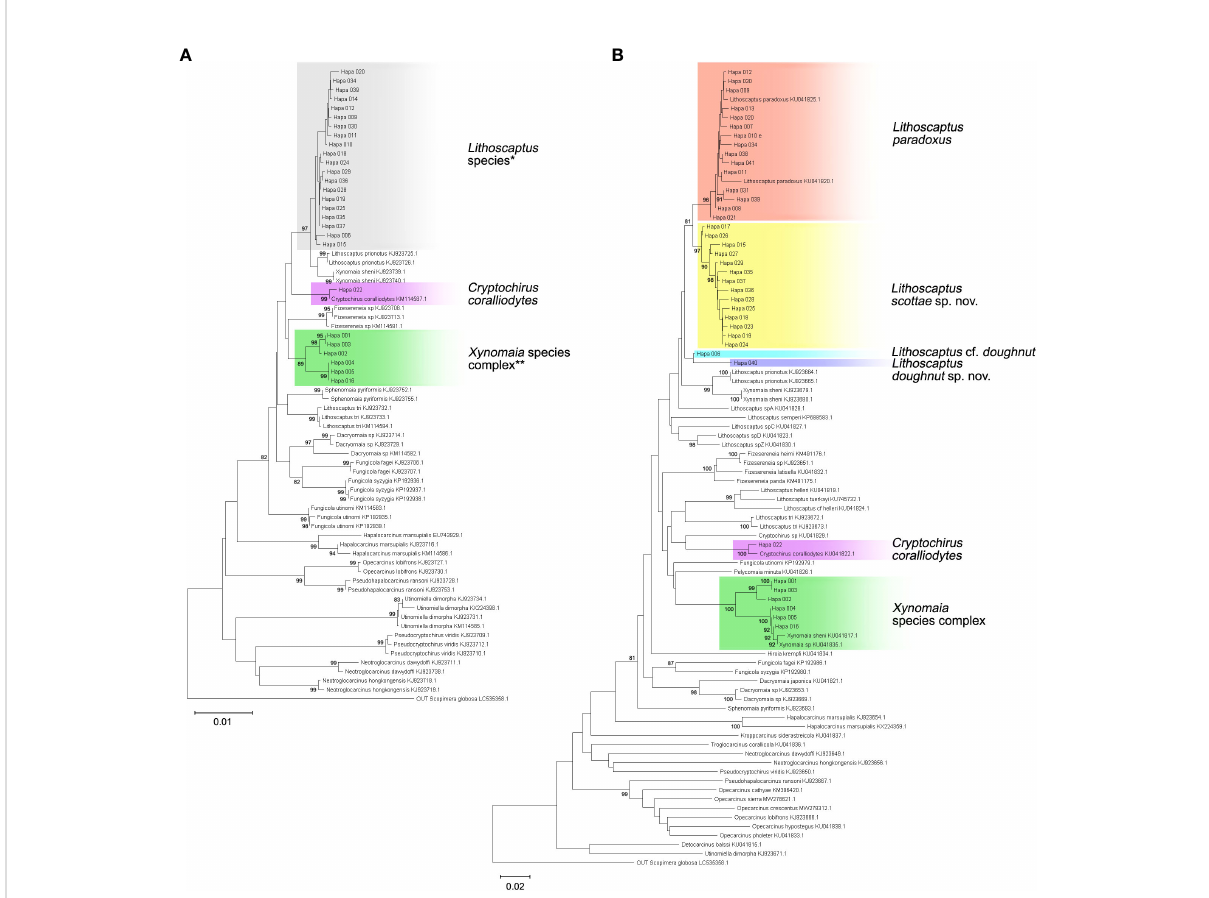
FIGURE 6 Neighbor-joining (NJ) tree of 16S rDNA (A) and COI sequences (B) . Branch length represents Kimura 2-parameter (K2P) distances, and bootstrap values are shown on the nodes when >80. Details of specimens from the present study (clades highlighted in gray), and reference sequences acquired from Genbank are listed in Appendix 1. Resolution of molecular analyses based on 16S rDNA sequences (A) do not allow identi fi cation of clades containing Lithoscaptus (*) and Xynomaia species complex (**). Depictions of both clades are inferred from reconstruction based on COI sequences (B)